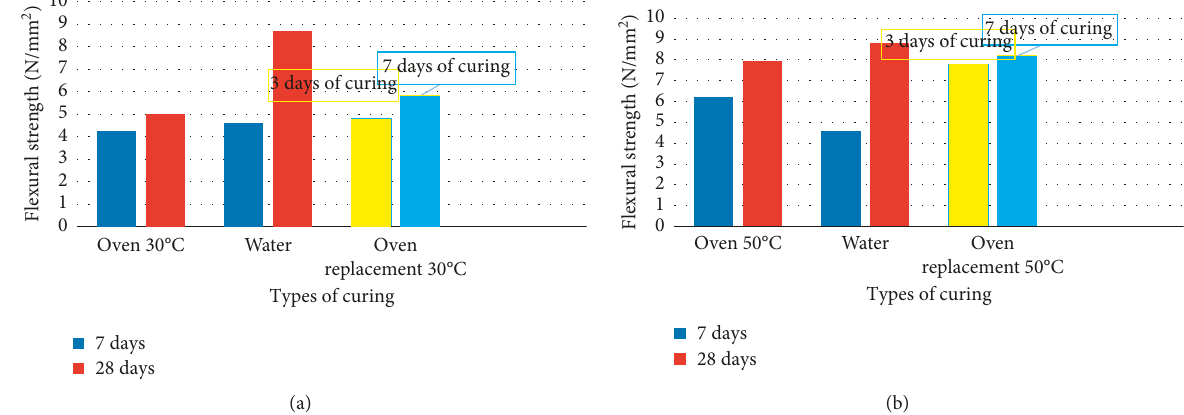
Figure 5: Flexural strength of concrete specimens with a W/B ratio of 0.35 prepared and cured under different conditions at a temperature of (a) 30 ° C and (b) 50 ° C.